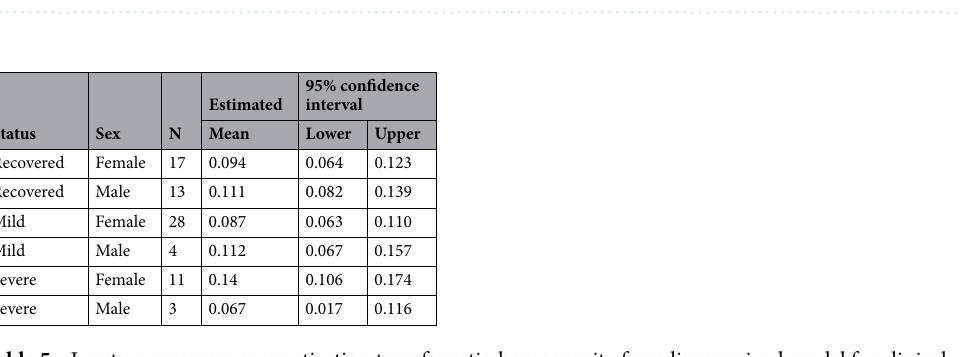
Table 4. ANOVA results between clinical group white matter tract magnetization transfer ratio (MTR) homogeneity and MTR homogeneity (MTR h ) means using status and sex as factors. White matter tracts above are the left and right combined spinothalamic and spinoreticular tracts (L and R SPTH).